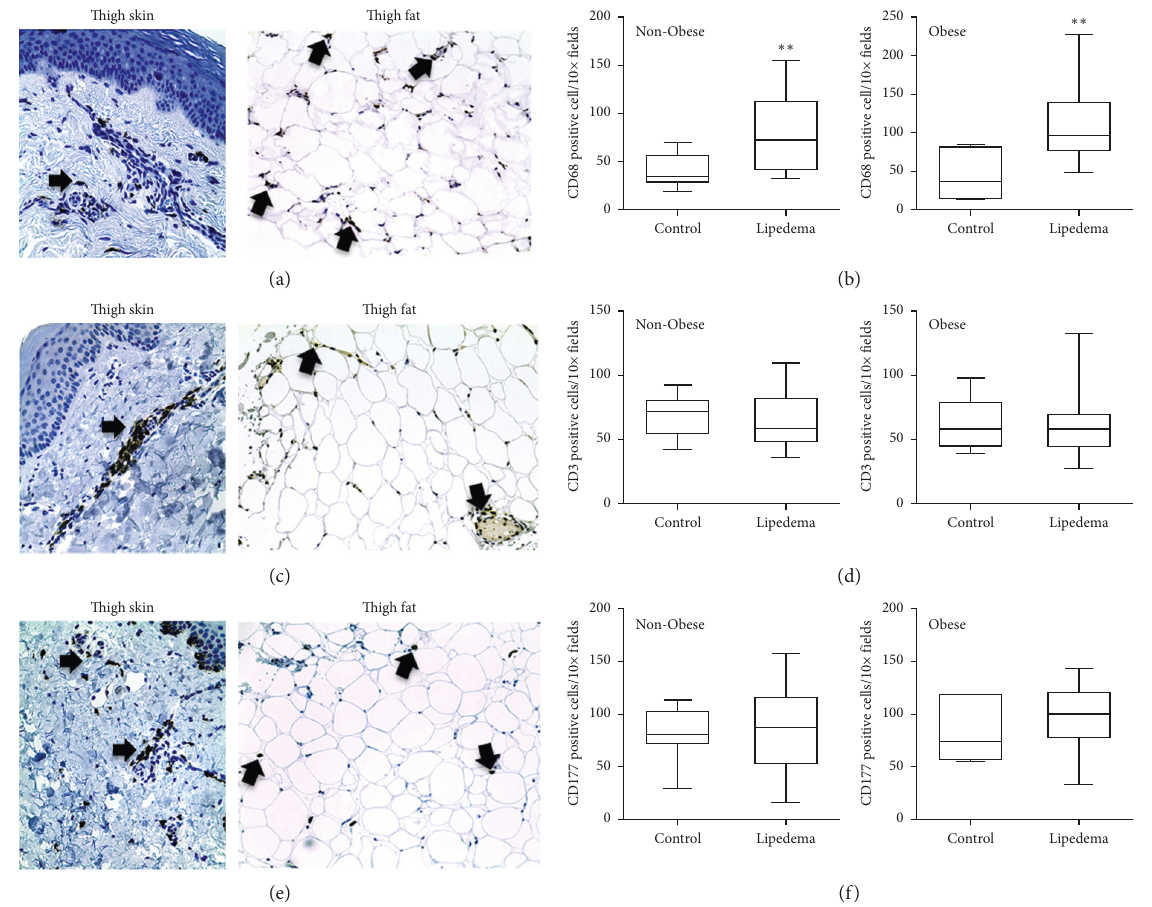
Figure 2: Immunohistochemistry of (a) CD68-labeled macrophages, (c) CD3-labeled T-lymphocytes, and (e) CD117-labeled mast cells in leg fat of lipedema participants (arrows). Images captured with 20x objective lens. Box and whisker plots of (b) CD68, (d) CD3, and (f) CD117cell counts in skin and fat of control and lipedema participants. Non-Obese group (Control n p 0 . (Control n 7; Lipedema n 12) ( (cid:31) (cid:31) ∗∗ <